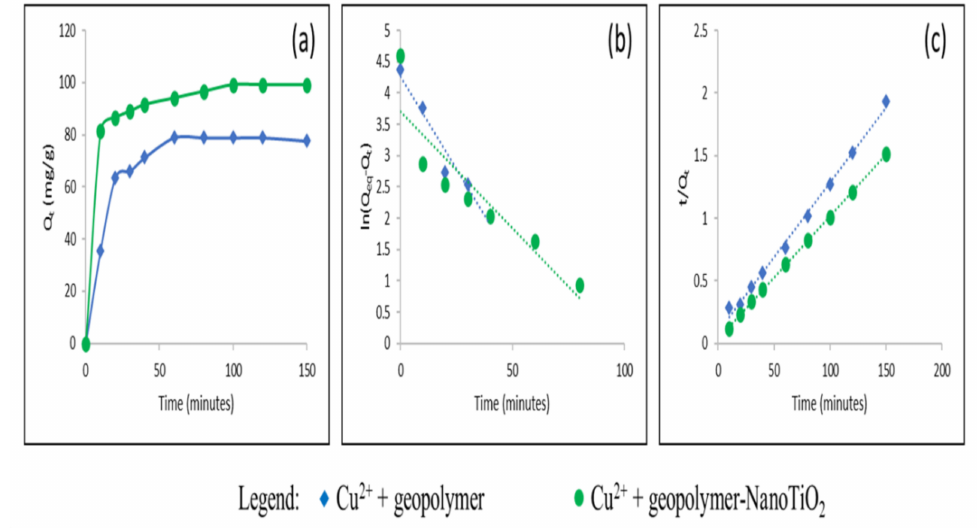
Figure 4. ( a ) Kinetic model of Cu 2+ on geopolymer and geopolymer-NanoTiO 2 composite (volume (15 mL), mass of adsorbent (0.3), pH (6.8), ambient temperature, and stirring speed (250 rpm)), ( b ) Pseudo First Order, ( c ) Pseudo Second